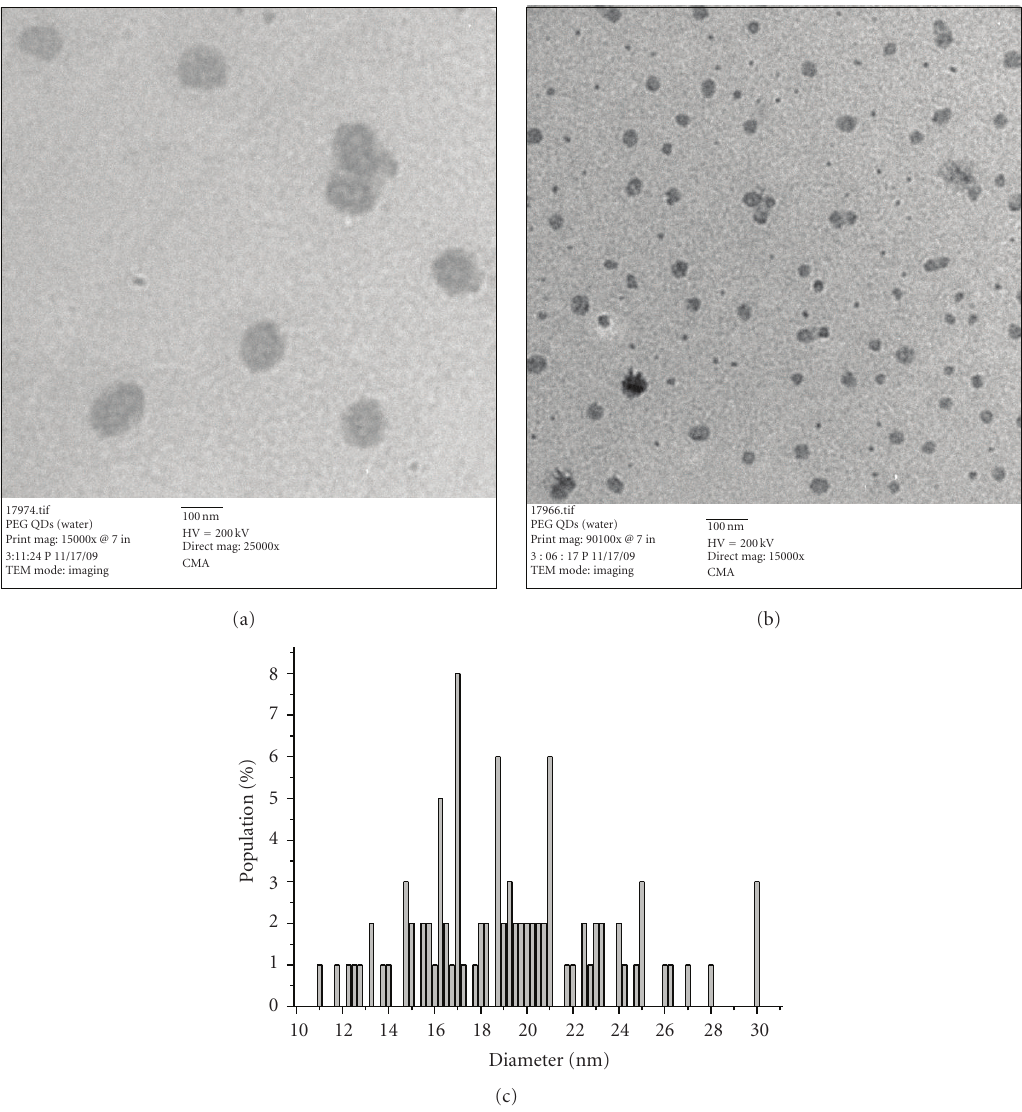
Figure 11: ((a), (b))TEM images of PEG-capped QDs (scale bar 100 nm). (c) Diameter distribution of PEG-capped QDs.